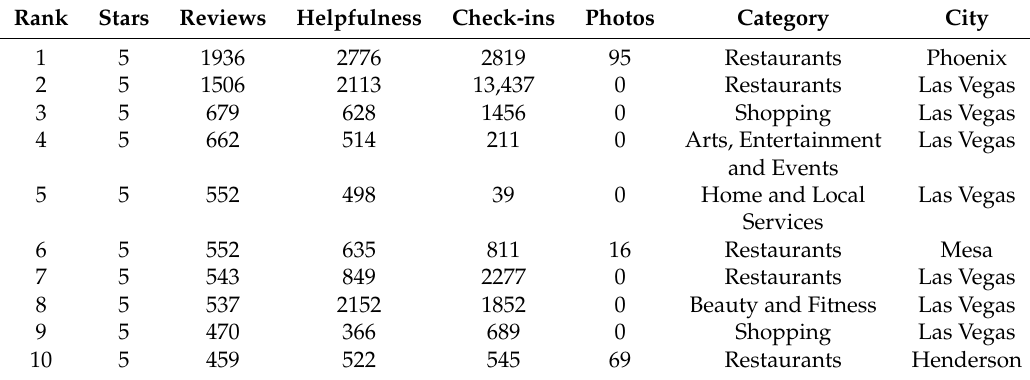
Table 3. Top 10 five-star businesses by review count.